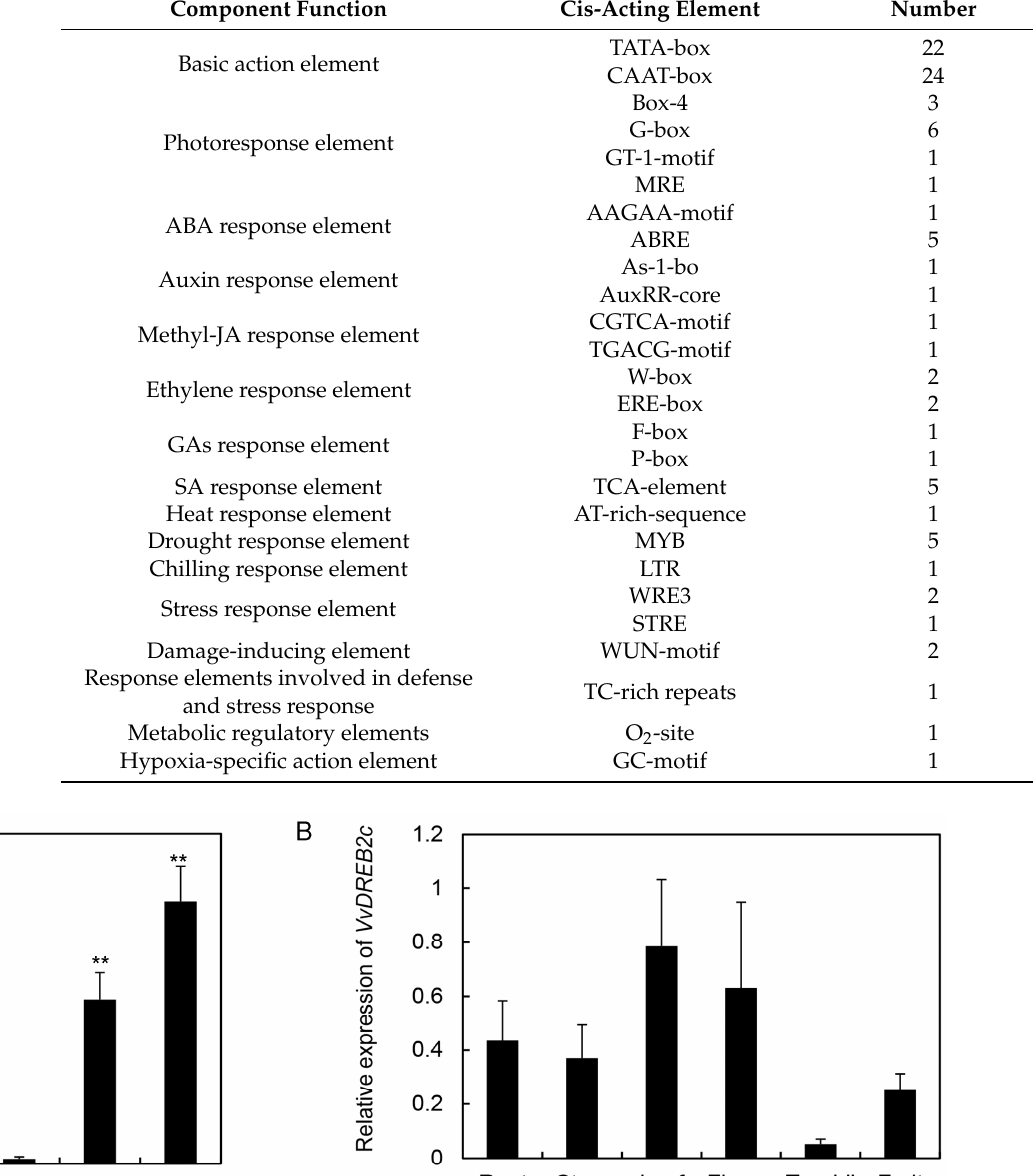
Table 1. Distribution of promoter elements in the promoter region of VvDREB2c in grape.